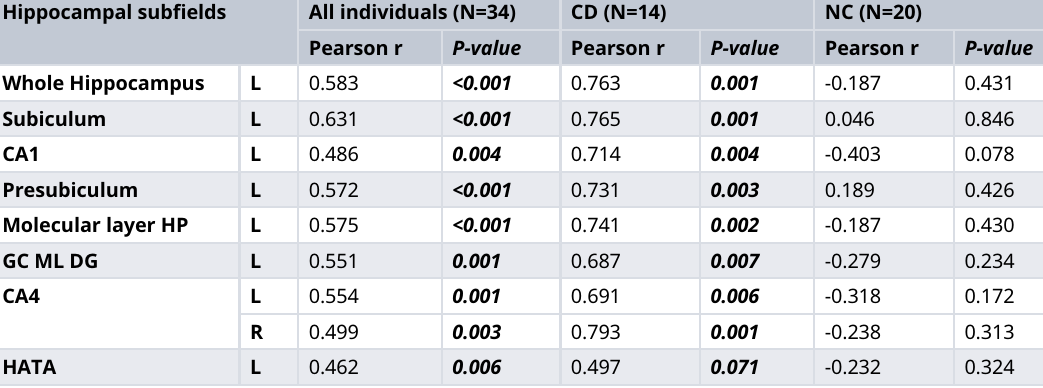
Table 3. Correlations between selectedhippocampal subfields volumeand adjMMSEin all individuals,CD and NC groups. L=left side; R=right side. Correlations were established using Pearson's correlation analysis. Hippocampal